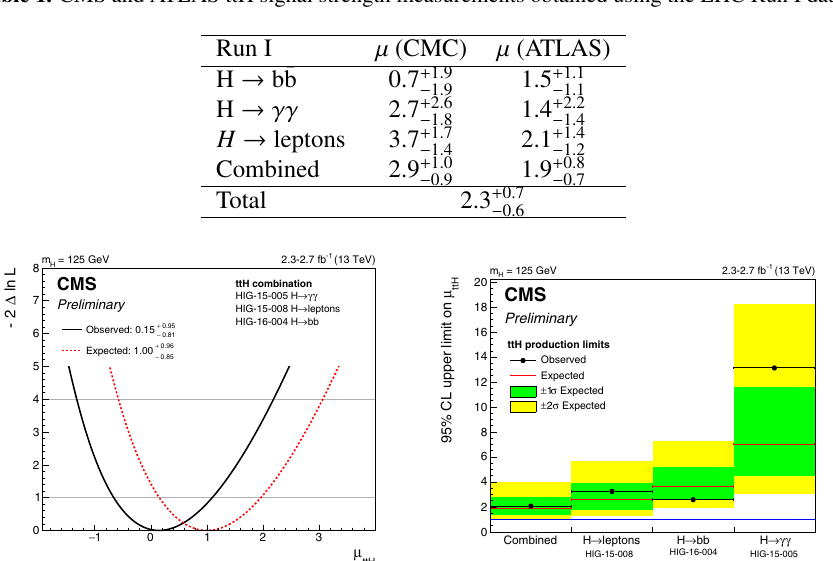
Figure 2. Combined signal strength measurement of the t¯tH production process, µ ttH , via decays of the Higgs boson to b¯b [3], γγ (ttH-tag categories only) [5] and multilepton [7] using 2 . 3 − 2 . 7fb − 1 of data collected at 13 TeV (left). Corresponding 95% confidence level upper limits on the rate of t¯tH production relative to the SM expectation, µ ttH = 1